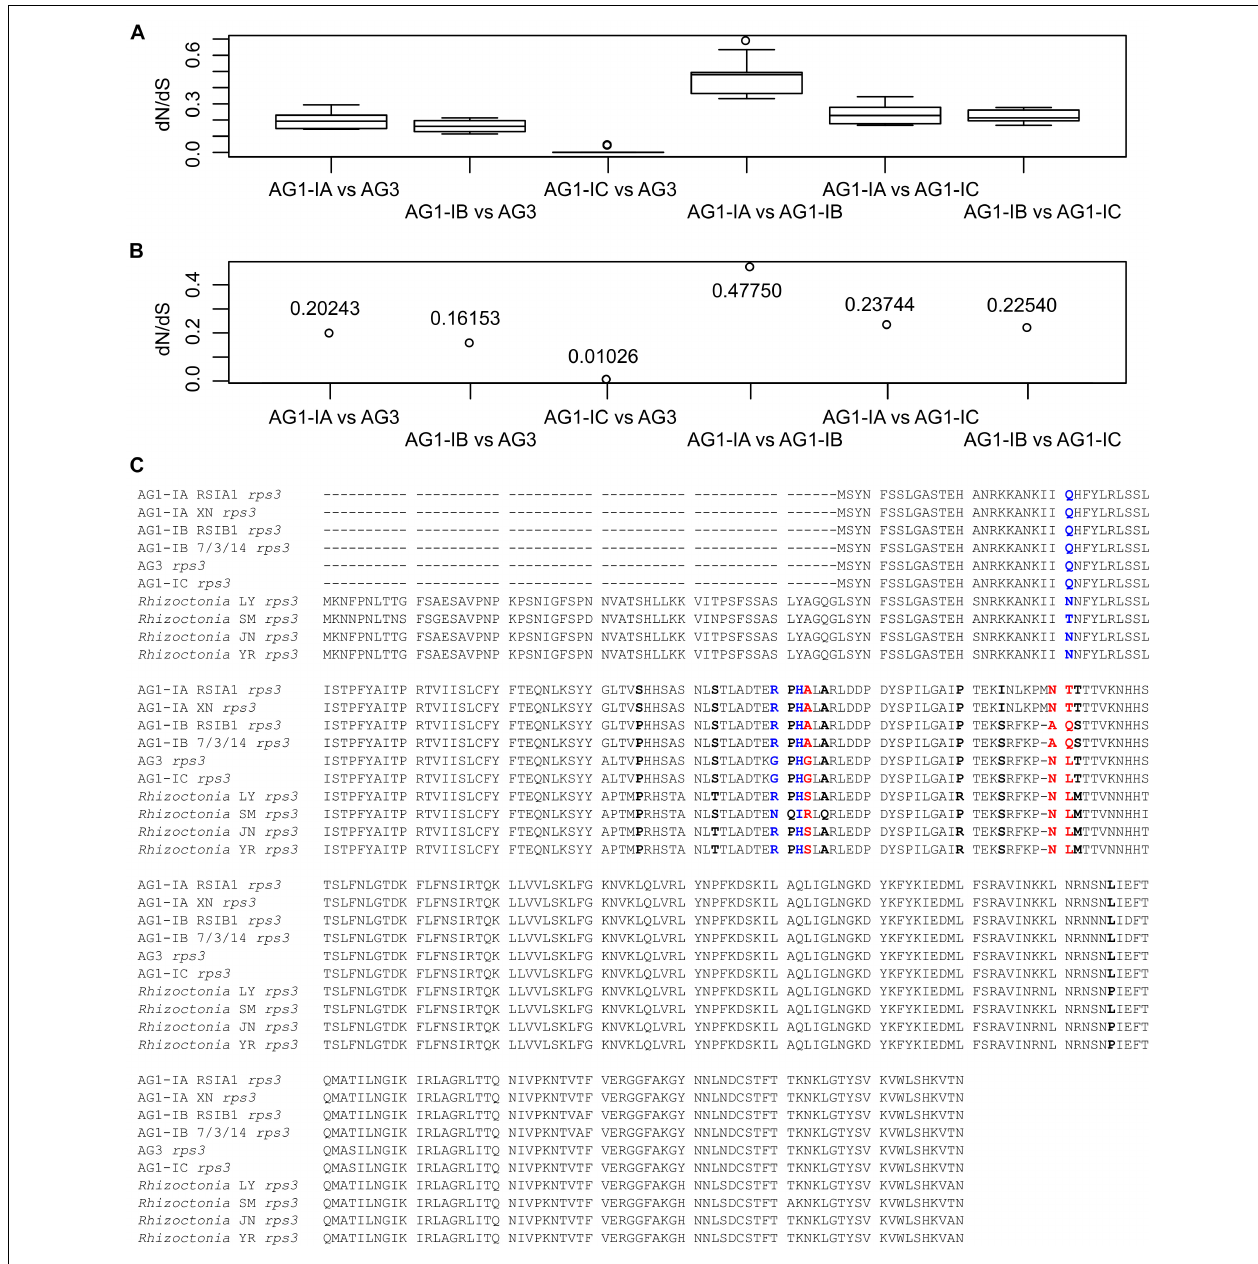
FIGURE 4 | Detection of positively selected sites in rps3 . (A) The dN/dS values for each pair of rps3 genes from mitogenomes. The dN/dS values were calculated by 10 methods implemented in the KaKs_Calculator. (B) The mean of the estimated values shown in (A) . (C) Display of positively selected sites in rps3 genes. The 14 positively selected sites were detected by the CODEML program in PAML, including three sites (in blue) with P > 95% and three sites (in red) with P > 99%.